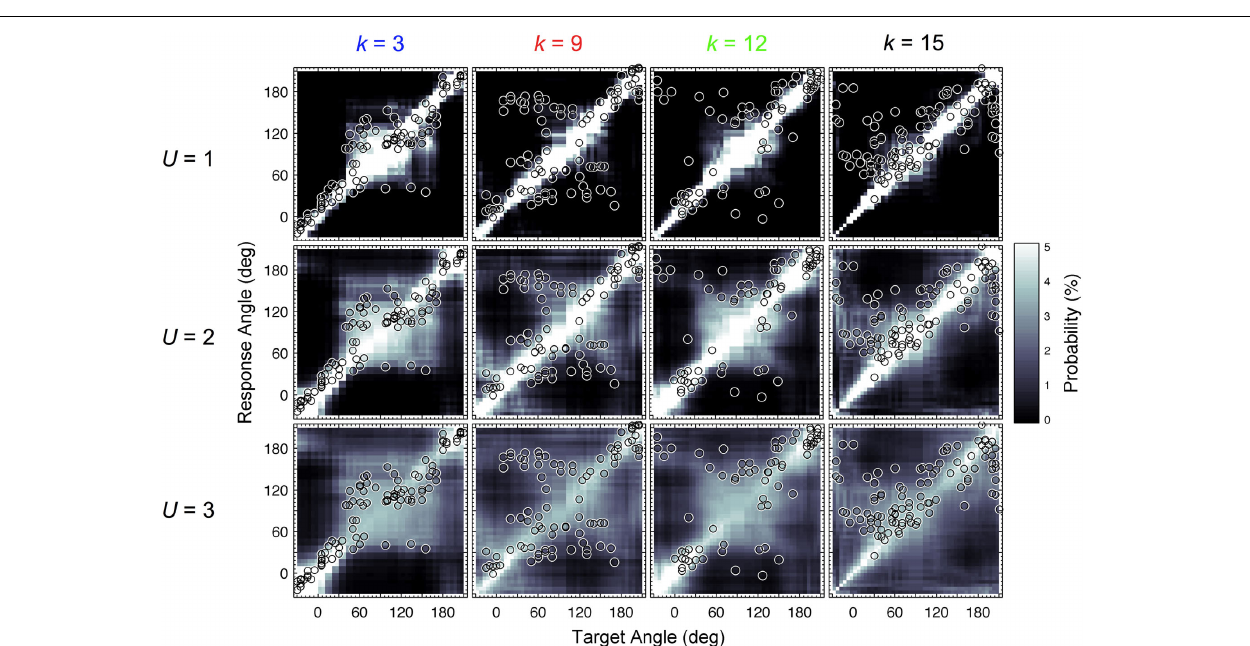
FIGURE 2 | Actual and modeled localization. Actual localization responses (circles) and modeled response probabilities (PMVs, brightness encoded) calculated for three uncertainties U and four exemplary listeners indexed by k .